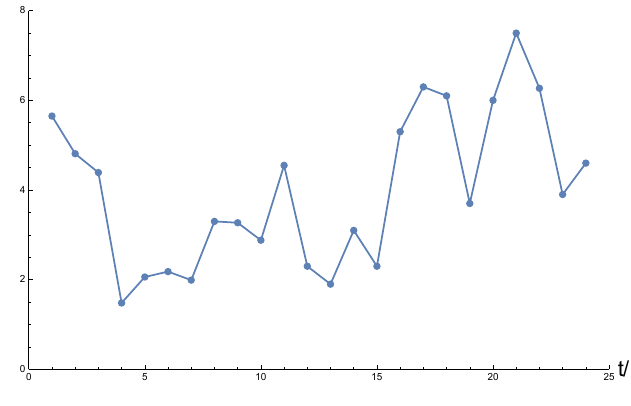
Figure 4. 24-hour ahead wind speed